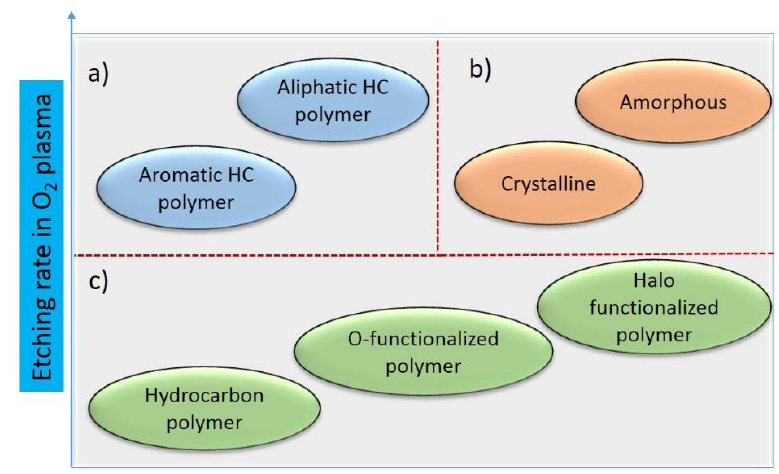
Figure 7. General schematic of the etching rate for various types of polymeric materials in O 2 plasma. ( a ) Dependence of etching rate on the aliphatic/aromatic behavior of the monomer units. ( b ) Etching rate dependence on the crystallinity. ( c ) Functionality dependence of the polymer with etching rate.